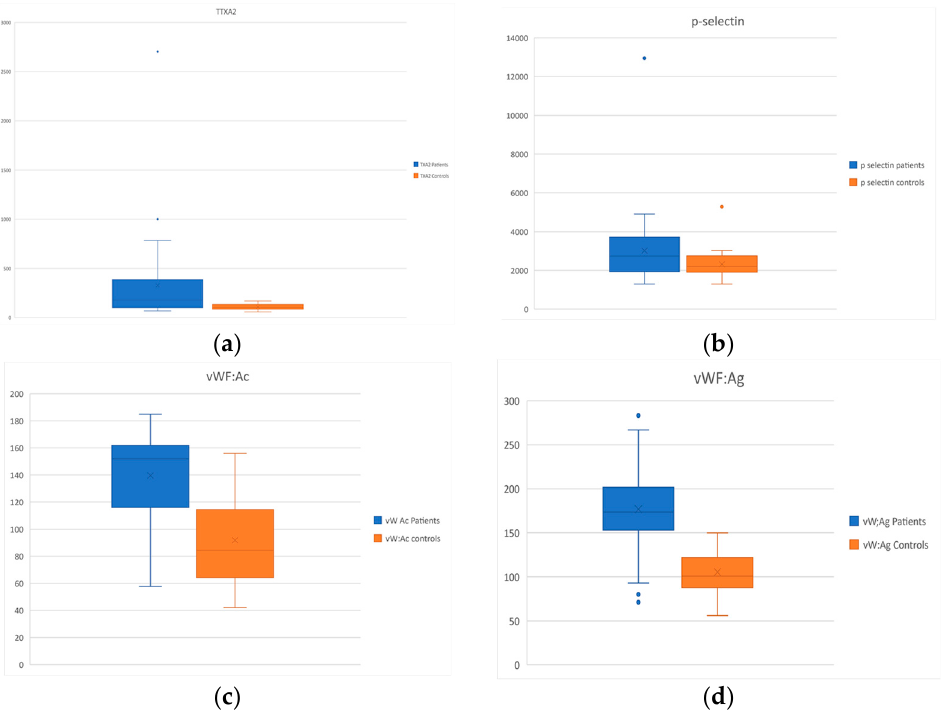
Figure 7. Box and Whisker plots of the results of the assays assessing markers of platelet activation and endothelial dysfunction. ( a ) TXA2; ( b ) p-selectin; ( c ) vWF:AC; ( d ) vWF:Ag.